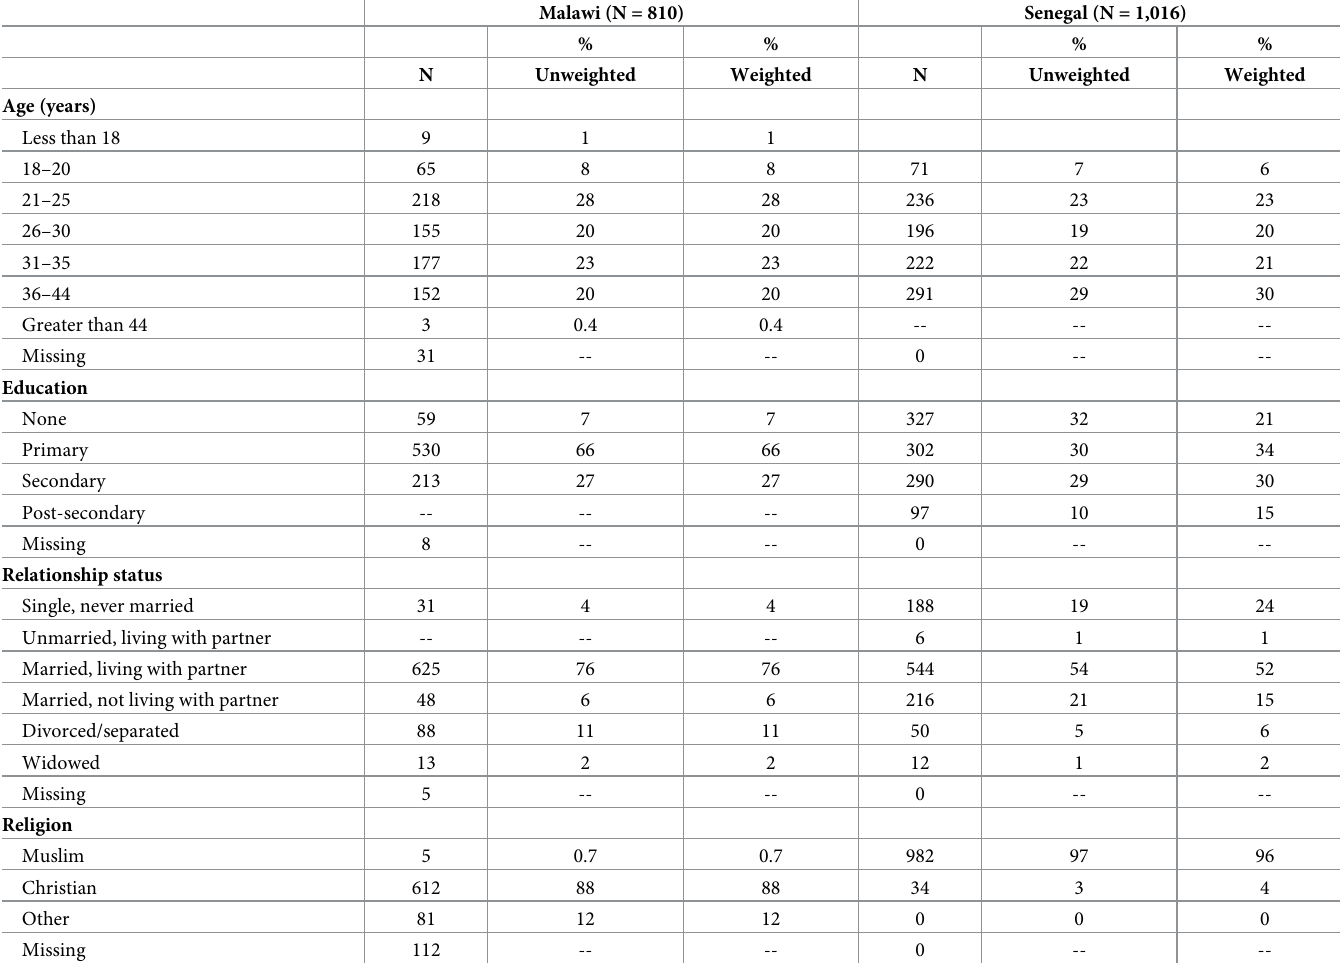
Table 1. Selected sociodemographic characteristics of a probability sample of participants in a household survey of cisgender women of reproductive age in Lilongwe, Malawi (n = 810), and Dakar, Diourbel, Louga and Ziguinchor regions in Senegal (n =